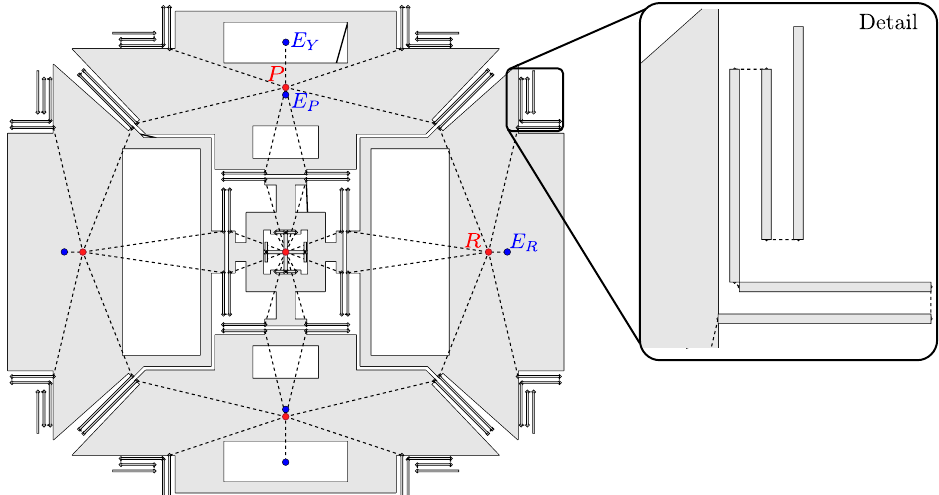
Figure 5. Device-level representation of the MEMS